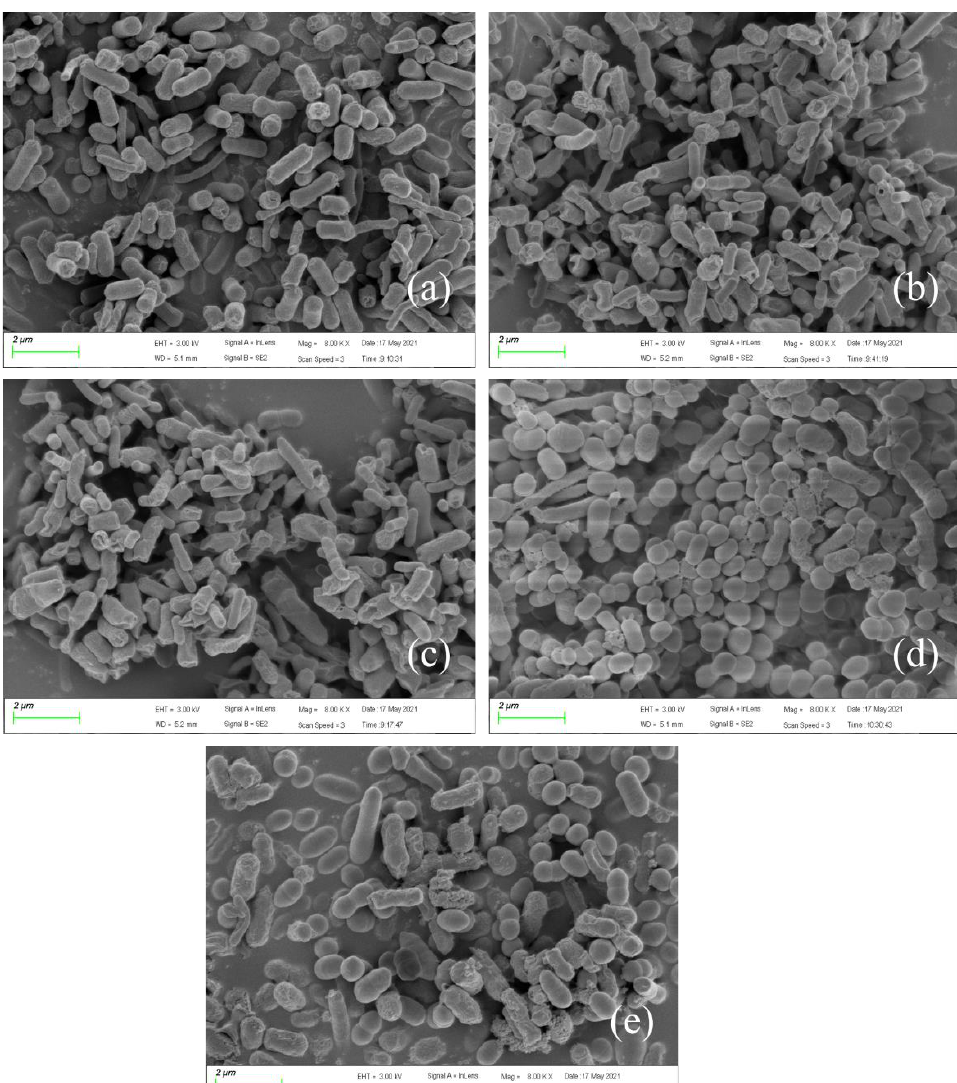
Figure 5. SEM images of E. coli strain 2 under different pressures: ( a ) 0 MPa, ( b ) 0.1 MPa, ( c ) 0.15 MPa, ( d ) 0.2 MPa, and ( e ) 0.3 MPa (the magnification is 4500×; the scale bar = 2 μm). SEM, scanning electron microscopy.